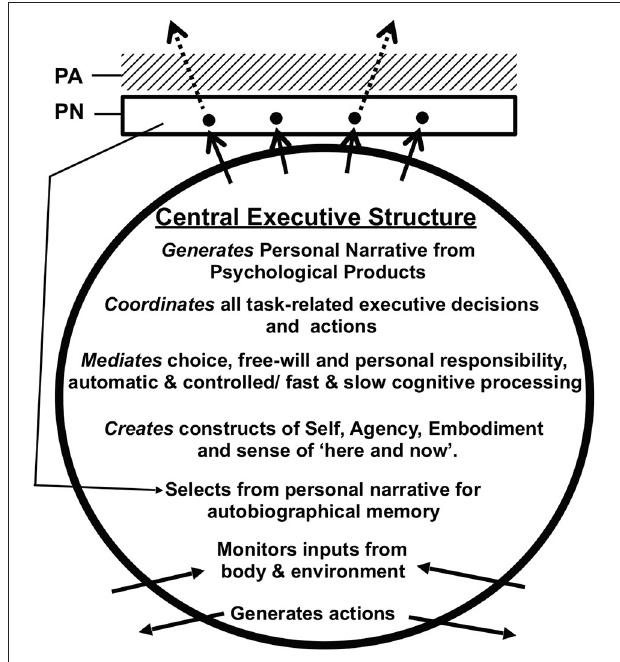
FIGURE 2 | Abbreviated version of the Oakley-Halligan model of cognitive psychological function. For the full version see Oakley and Halligan (2017). The Central Executive structure creates and orchestrates all the cognitive psychological processes carried out by the brain. The solid arrows at the top of the model represent the process of Internal Broadcasting that underlies the creation of an ongoing Personal Narrative (PN). The dotted arrows represent the process of External Broadcasting whereby selected contents of the personal narrative can be communicated particularly, but not solely, via language, to other individuals facilitating social collaboration and the creation of a cultural store of ideas, skills, and information. Personal Awareness (PA) is an epiphenomenal subjective experience that passively accompanies the contents of the personal narrative. Also shown is the linkage between contents of the PN and autobiographical